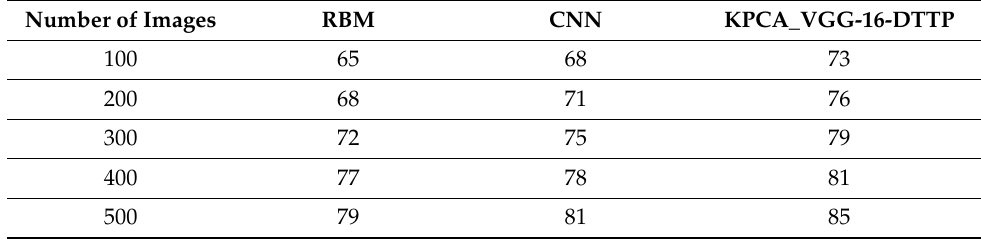
Table 2. Comparative analysis of